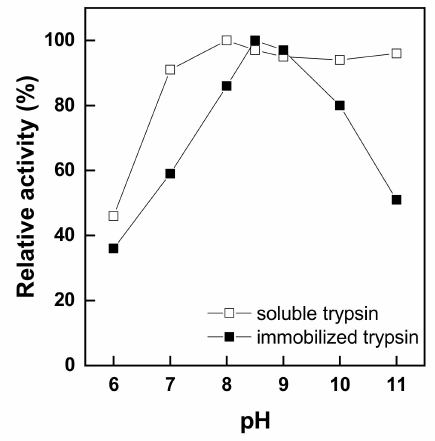
Figure 6. pH stabilities of soluble and immobilized